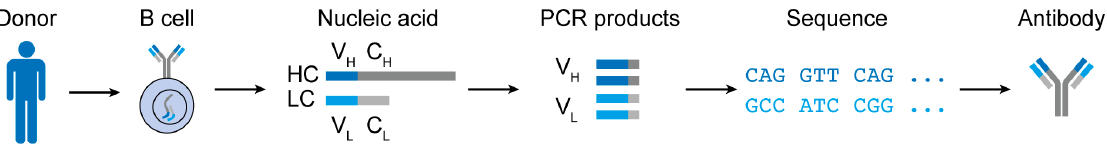
Figure 2. Analyzing B cell receptors from human donors. B cells are isolated, and DNA or RNA is extracted and subjected to B cell receptor sequence amplification. Amplicons are sequenced and can be used for recombinant antibody production. HC: heavy chain, LC: light chain, V: variable region, C: constant region, V H : heavy chain variable region, V L : light chain variable region.